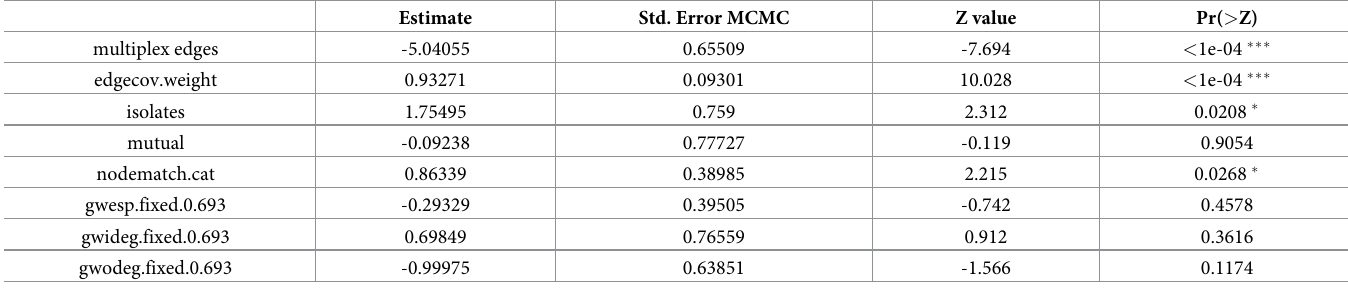
Table 7. Multiplexity in the beta community